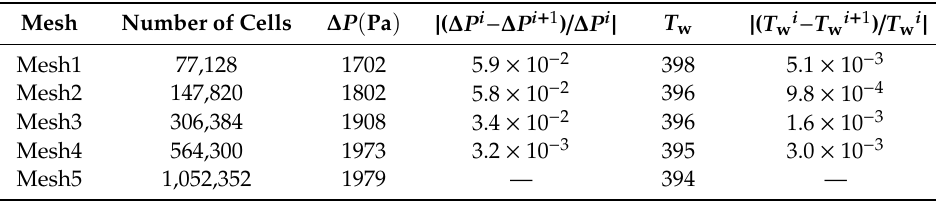
Table 2. Results of the mesh independence analysis.